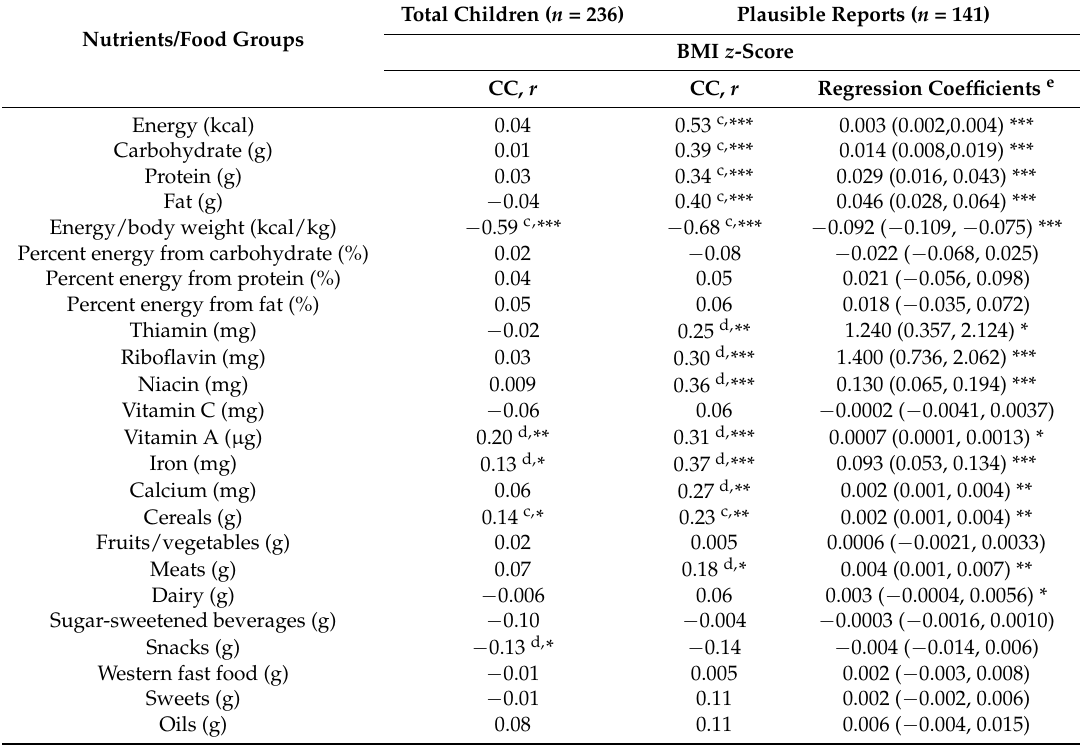
Table 4. Dietary intakes and BMI z -scores for all children and for plausible energy